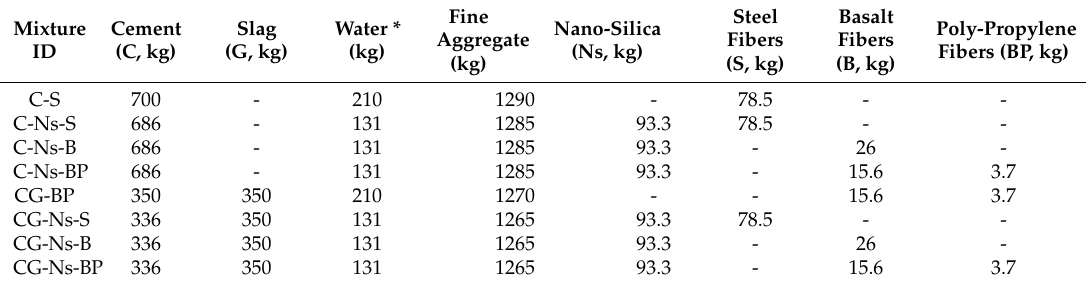
Table 3. Proportions of nano-modified fiber-reinforced mortars per cubic